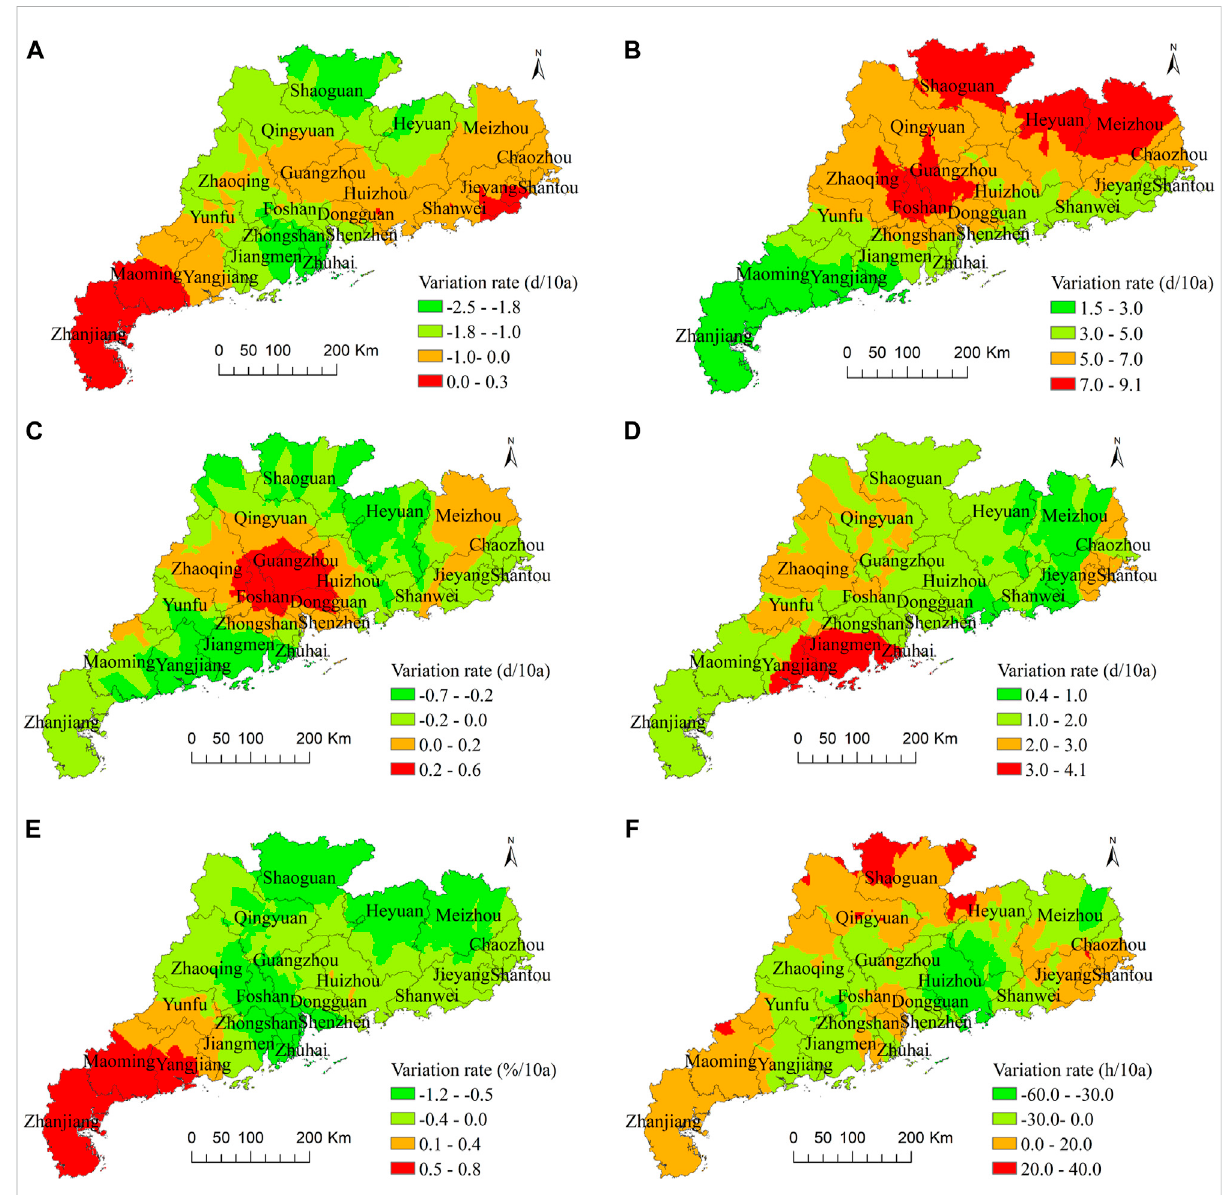
FIGURE 2 Thevariation tendencyspatialdistributionofhigh-impactclimatefactorsin1992 – 2018. (A) Low-temperaturedays. (B) High-temperaturedays. (C) Rainstorm days. (D) High wind days. (E) Average relative humidity. (F) Total hours of